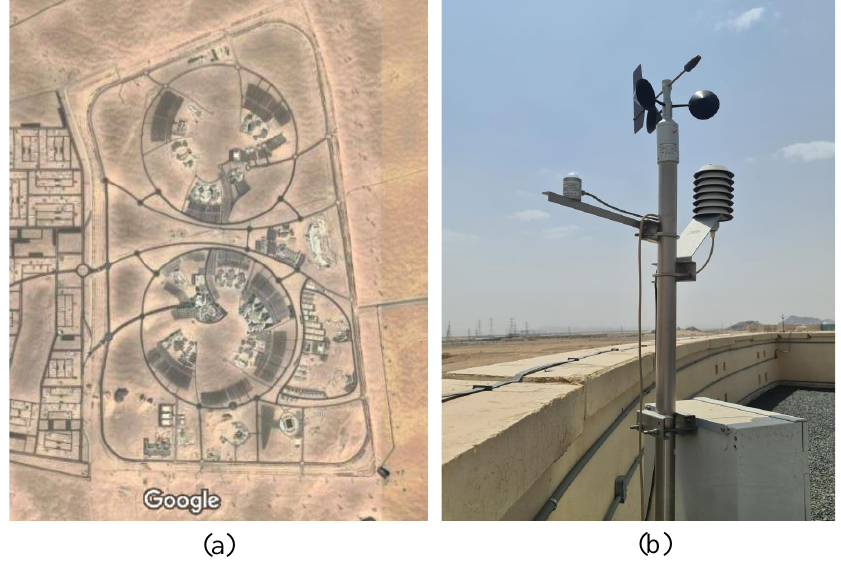
Figure 1. Site location used in this study. ( a ) Najran University; ( b ) Solar and wind weather